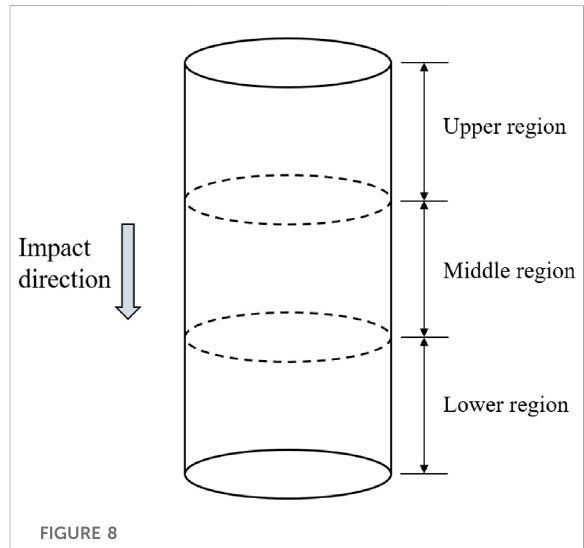
FIGURE 8 Schematic diagram of different regions of the